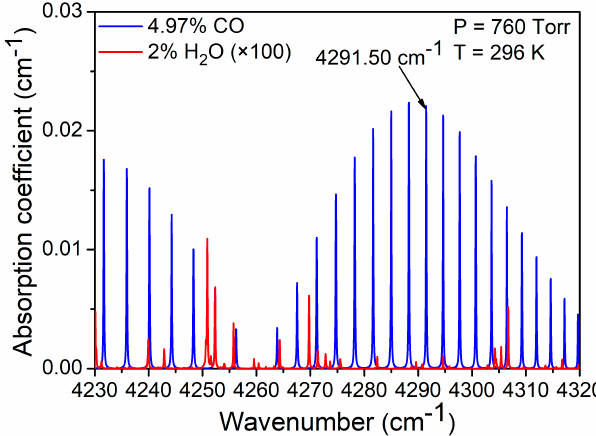
Figure 1. CO absorption lines in the 2.3 µ m first-overtone absorption band.